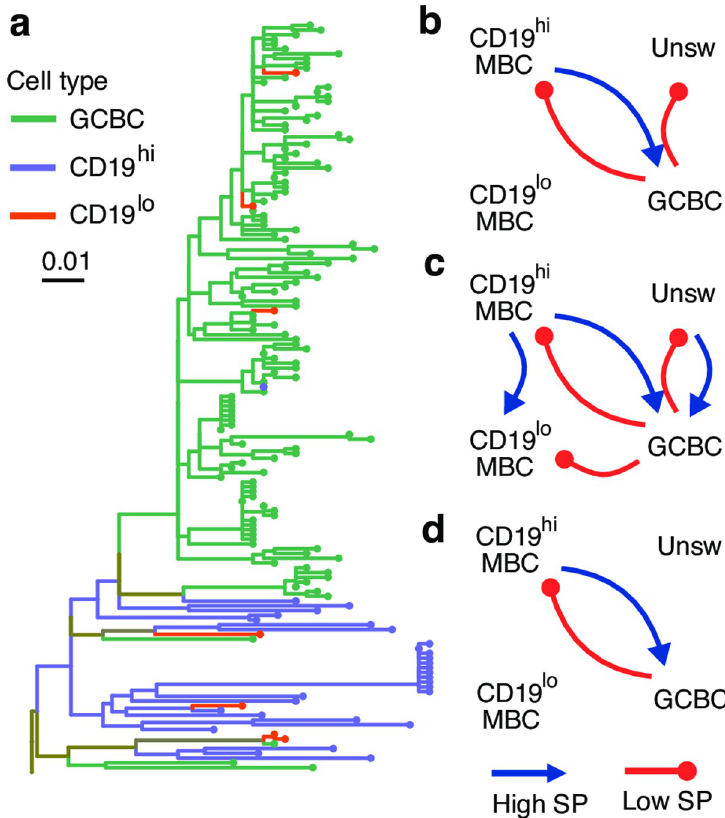
Fig 5. Analysis of B cell subtypes in three HIV+ subjects. (a) Example tree visualized using ggtree [38,39] showing observed relationship between CD19 hi MBCs and GCBCs. (b-d) Direction of significant SP test δ values for subjects 1 (b) , 2 (c) , and 3 (d) . Arrows within each diagram show the direction of significantly high (blue) or significantly low (red) SP statistics between CD19 hi MBCs, CD19 lo MBCs, unswitched MBCs (Unsw), and GCBCs in each